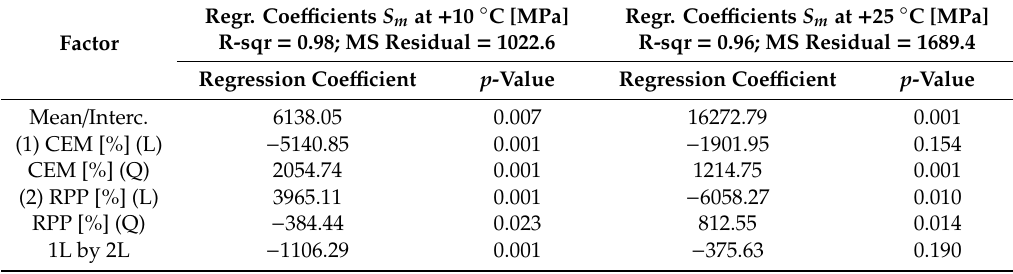
Table 12. Experimental coe ffi cients for sti ff ness modulus S m at + 10 and + 25 ◦ C. Factor